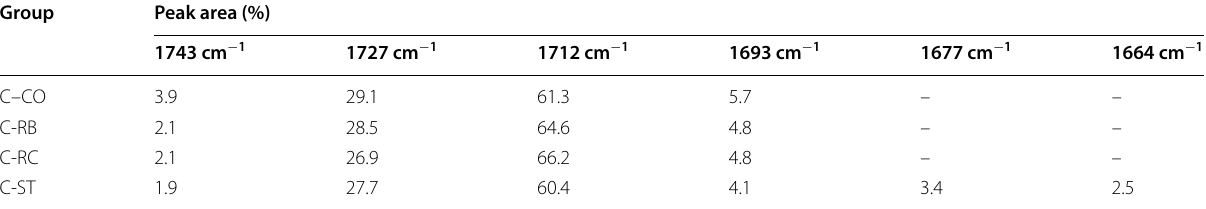
1727 cm − 1 : Free C O groups; 1712 cm − 1 : H–bonded C =